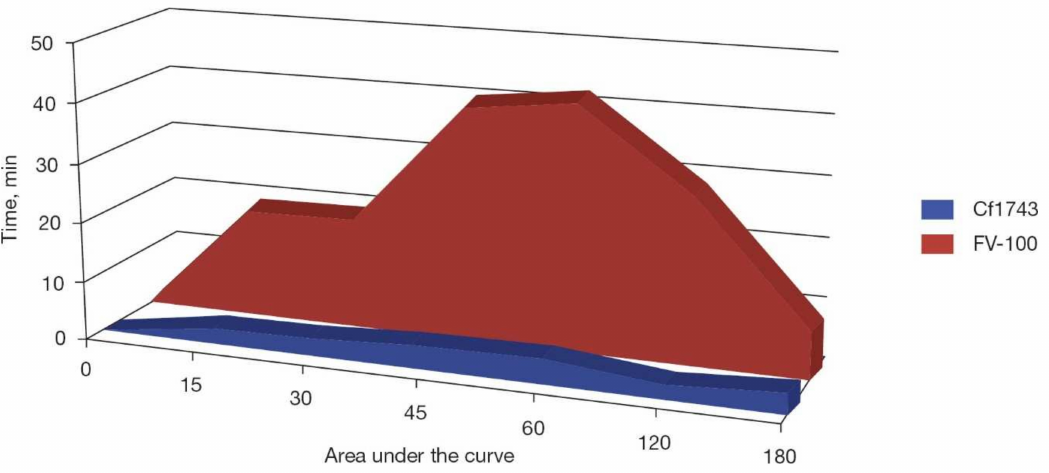
Figure 5. Oral bioavailability of FV-100 as compared to Cf1743 as monitored by area under the curve (AUC) versus time. (Figure from Ref.